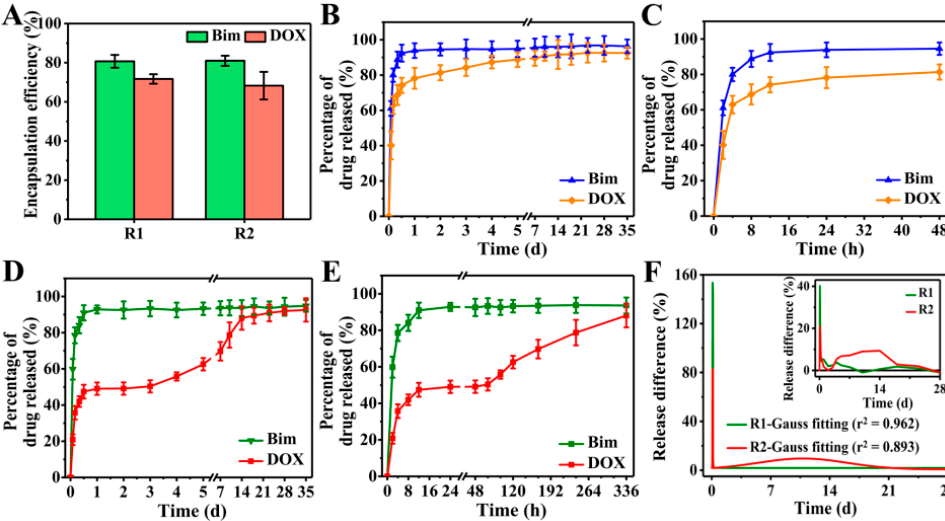
Figure 6. ( A ) Bim and DOX encapsulation efficiencies of R1 and R2 DDSs. Percentage of Bim and DOX released from R1 DDSs within ( B ) 35 days and ( C ) 48 h. Percentage of Bim and DOX released from R2 DDSs within ( D ) 35 days and ( E ) 336 h. ( F ) Release difference of DOX in R1 and R2 DDSs measured at every two detection time points: measured value (inset) and Gauss fitted value.